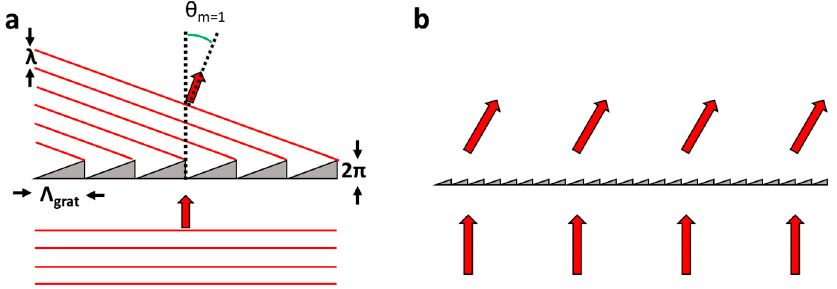
Figure 9. Micro and macroscopic picture of a blazed grating. ( a ) Shows how the 2 π phase delay leads to each micro prism modulating the incoming wave to redirect the wavefront, where the angle of redirection is determined by Equation (20). ( b ) Shows the macroscopic effects of this where the optical rays have deviated at a sufficient distance from the device (Fraunhofer diffrac- tion).